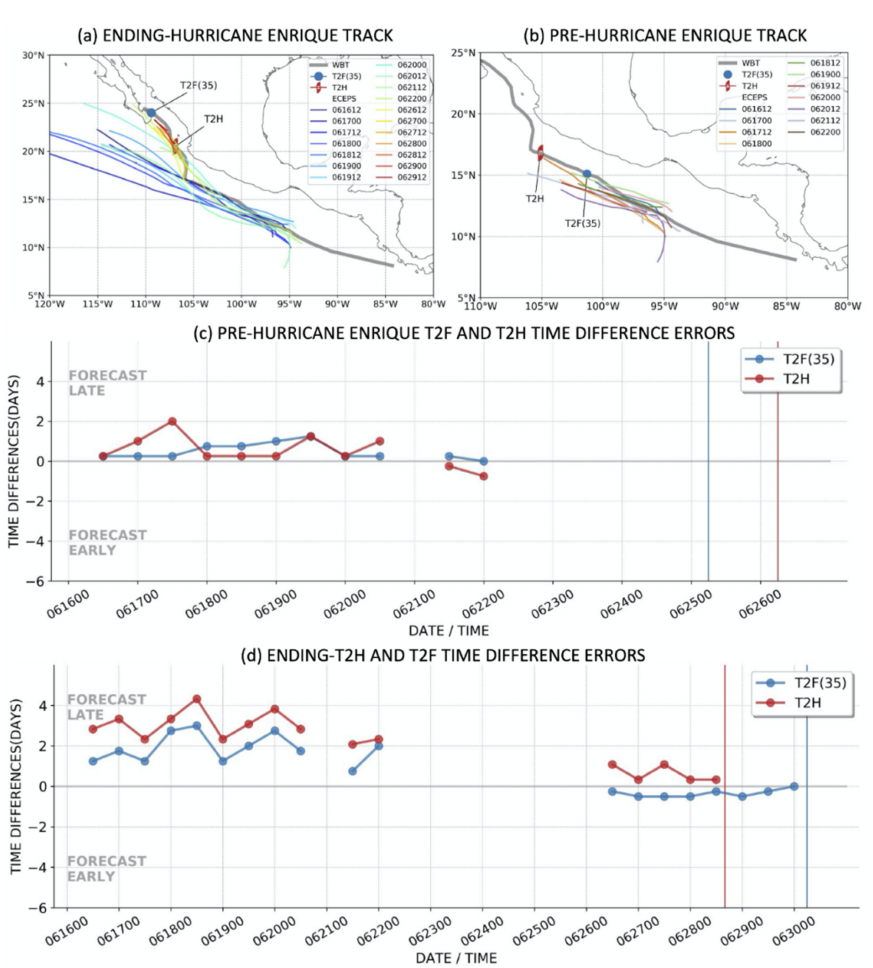
Figure 6. Summary of the ECEPS pre-formation and ending-stage predictions as in Figure 3 except for the Hurricane Enrique